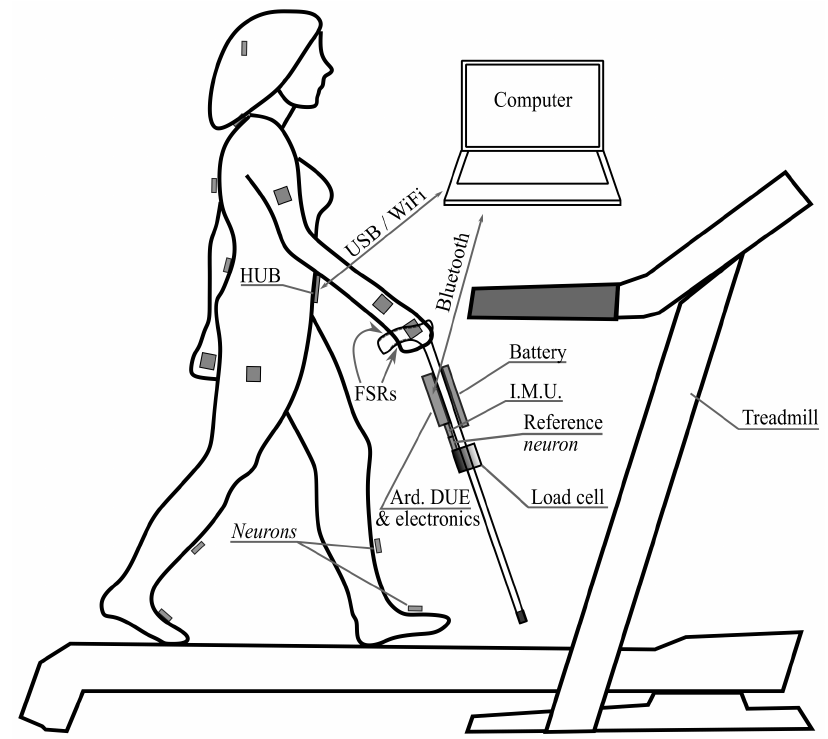
Figure 8. Experimental